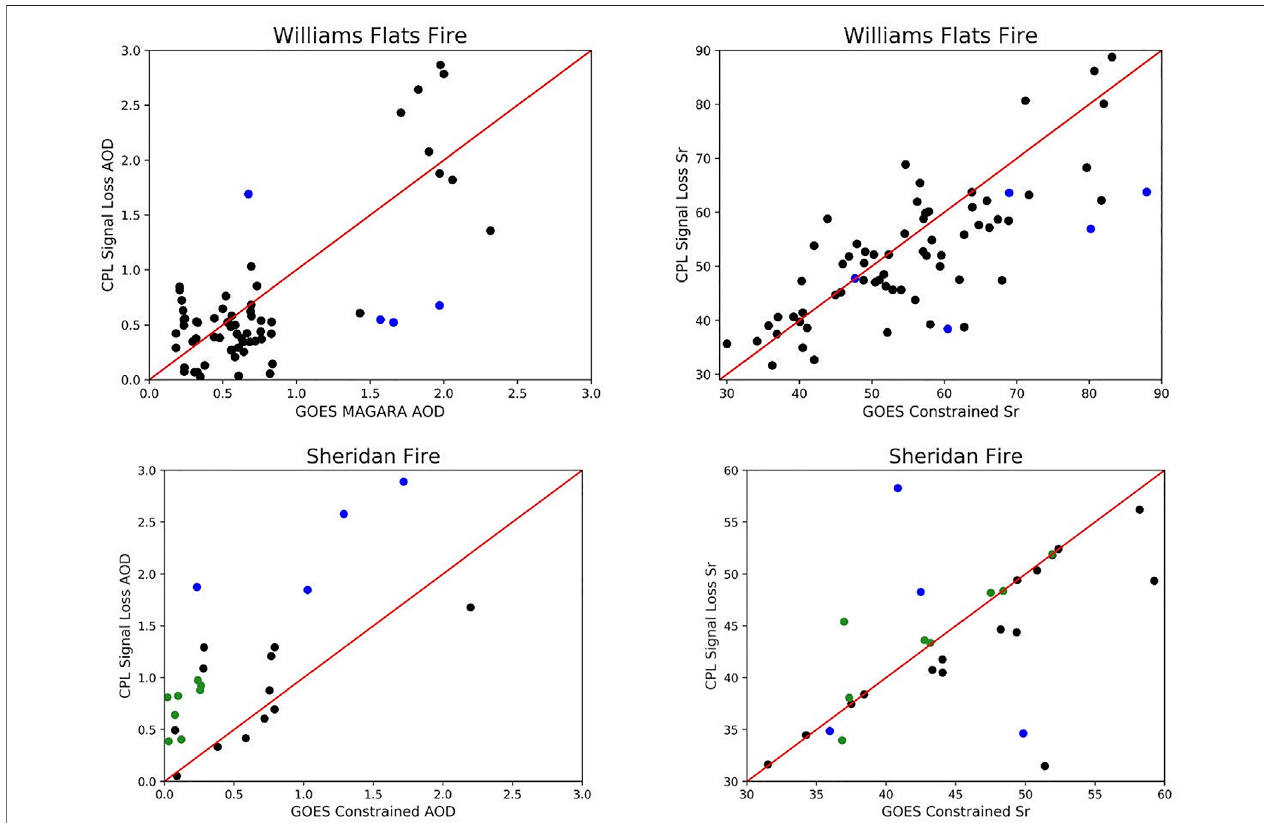
FIGURE9| Pointbypointcomparison ofcollocated GOES MAGARAAOD andCPLAOD retrievals(left)fortheWilliams FlatsandSheridan fi recasestudies, along with GOES MAGARA constrained lidar ratio values and CPL signal loss calculated lidar ratios (right). Blue colored points indicate values with larger discrepancies between the two retrievals likely due to potential MAGARA cloud masking biases or the effects of CPL layer boundary detection issues. Green colored points indicate values where the signal loss method has a high bias in the smoke plume AOD due to the presence of a tenuous layer above the primary smoke plume.